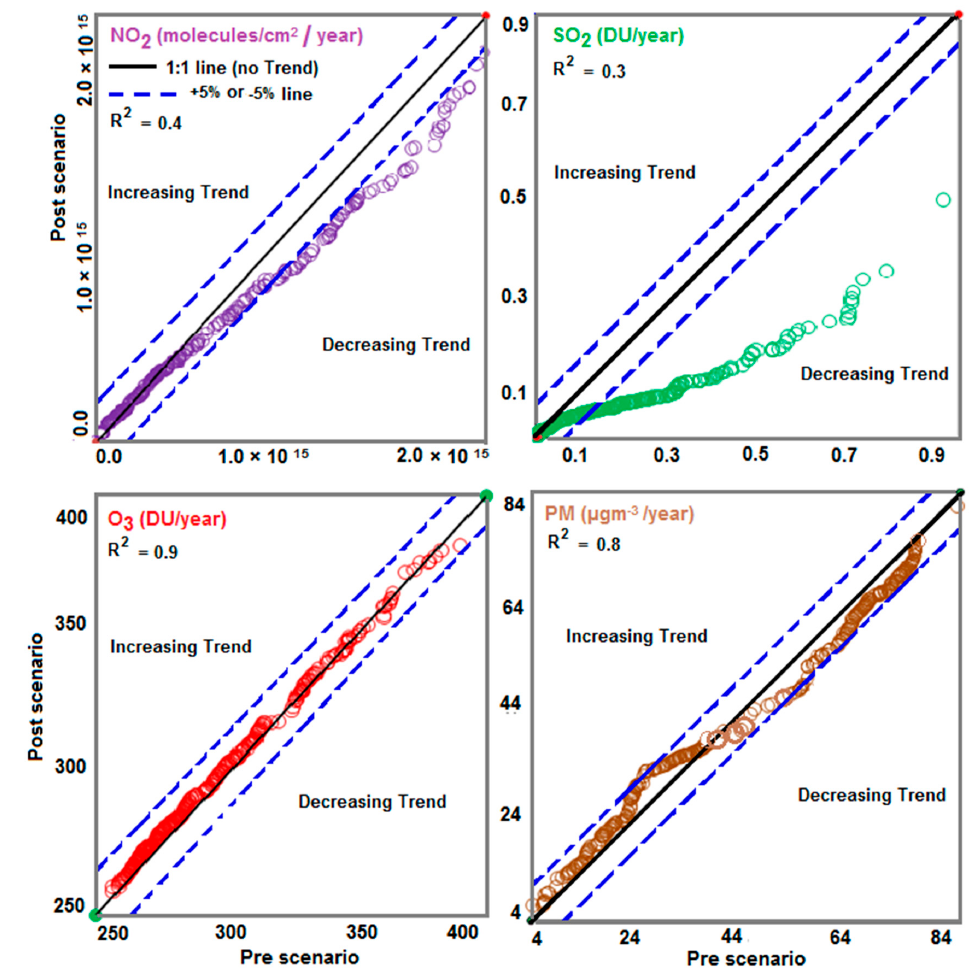
Figure 10. ITA trend of the pollutants (NO 2 , PM, SO 2 , and O 3 ). Note: Blue dotted line shows significance at ( p <